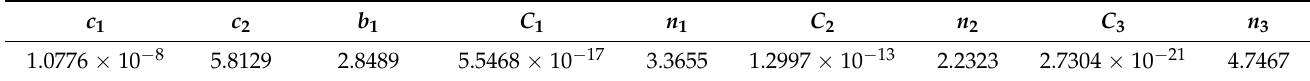
Table 2. The parameters of creep model at 600 ◦ C.